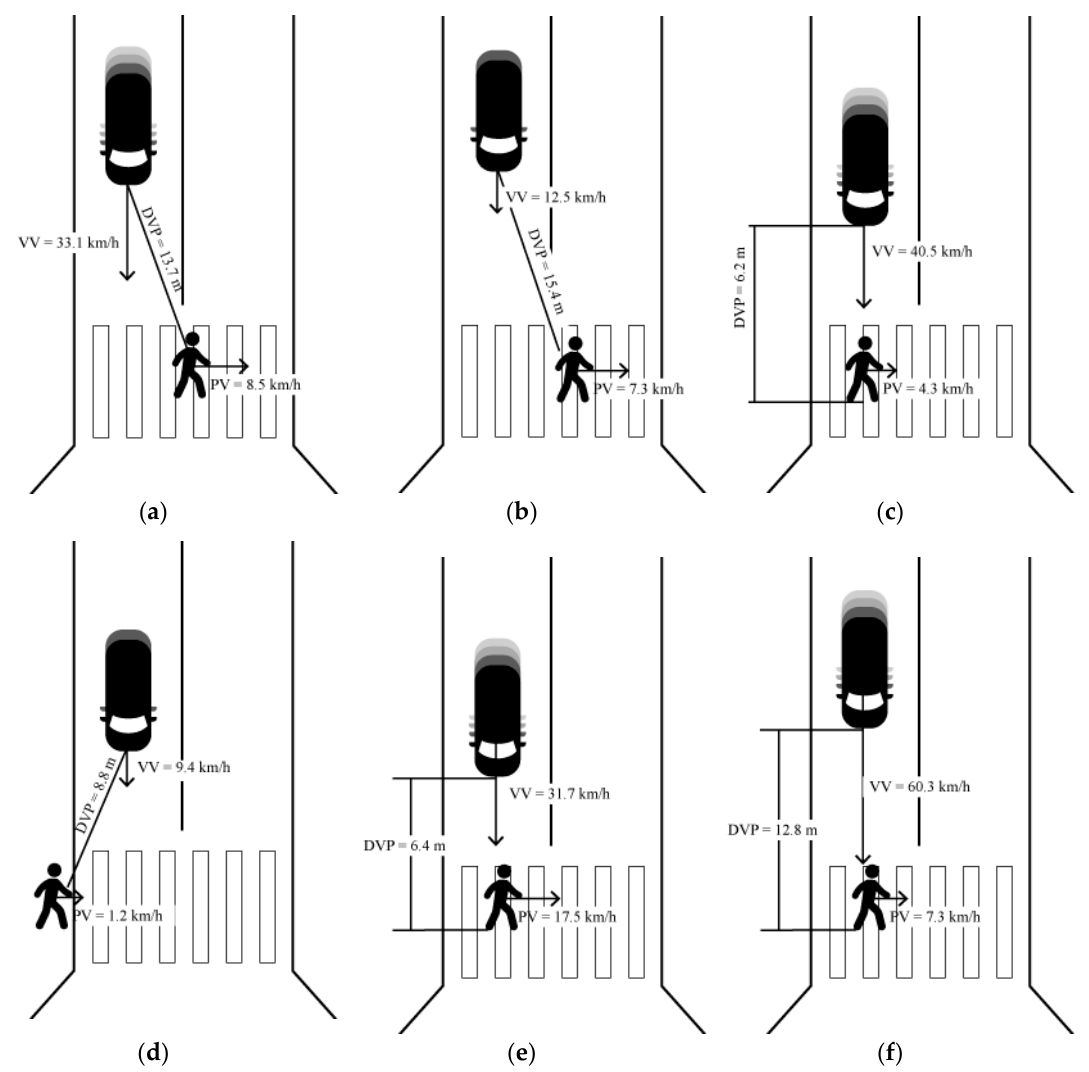
Figure 15. Examples of objects’ states based on rules in ( a ) cluster #0; ( b ) cluster #1; ( c ) cluster #2; ( d ) cluster #3; ( e ) cluster #4; and ( f ) cluster #5.